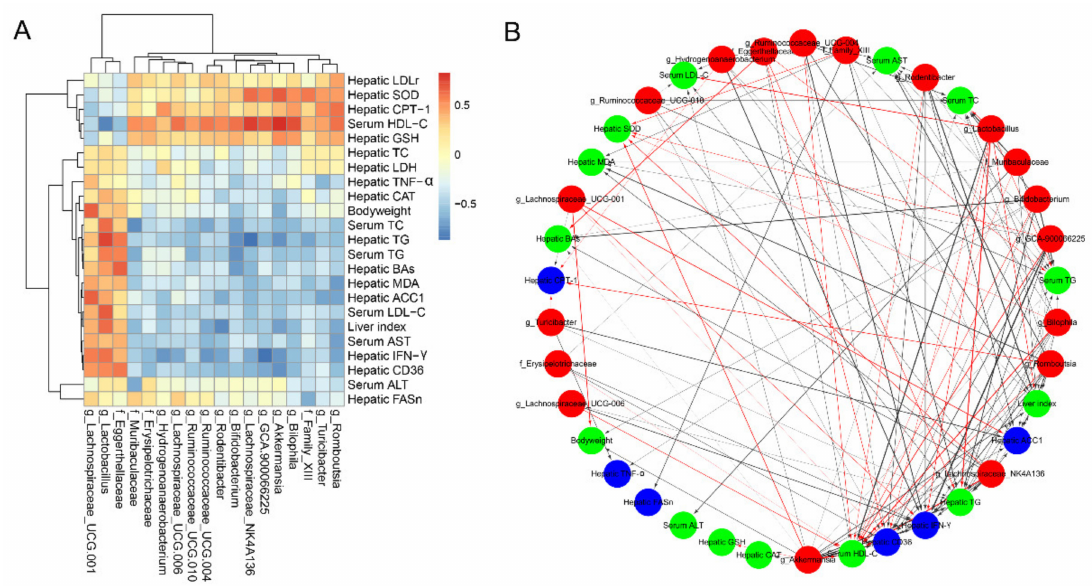
Figure 8. Spearman’s correlation of the key intestinal microbial phylotypes with metabolic parameters and liver gene transcription profile. ( A ) Correlation heatmap between the key microbial phylotypes and metabolic parameters; ( B ) Visualization of the correlation network according to the correlation. Red nodes: the key microbial phylotypes altered by AAM administration; green nodes: the metabolic parameters; blue nodes: lipid metabolism and inflammatory response related genes in liver. The red lines and black lines represent positive and negative correlations, respectively. Line width indicates the strength of correlation. Only the significant edges were drawn in the network based on the correlation test (|r| > 0.6, FDR adjusted p <